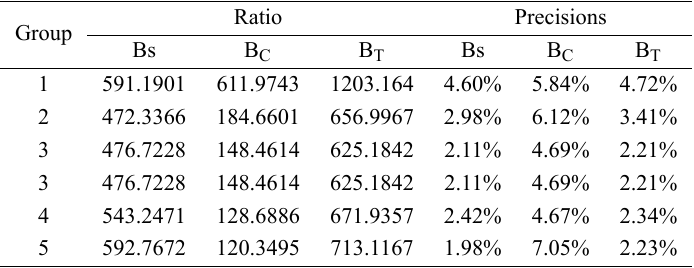
Coefficients and precisions obtained through procedure 1 to model the biomass of the components and total biomass as a function of the stem volume in stands of black wattle in the state of Rio Grande do Sul, Brazil. Ratio Group